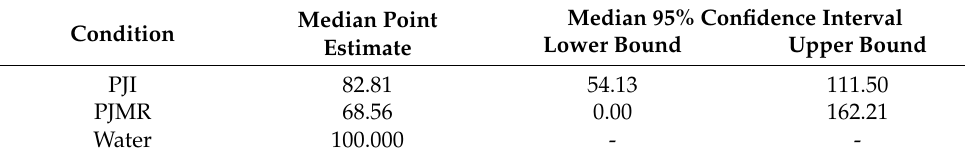
Table 1. Median cramp